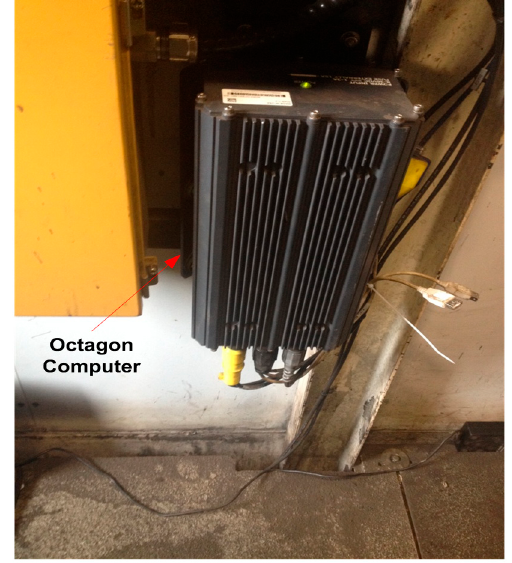
Figure 1. Octagon computer installed in the shovel house.